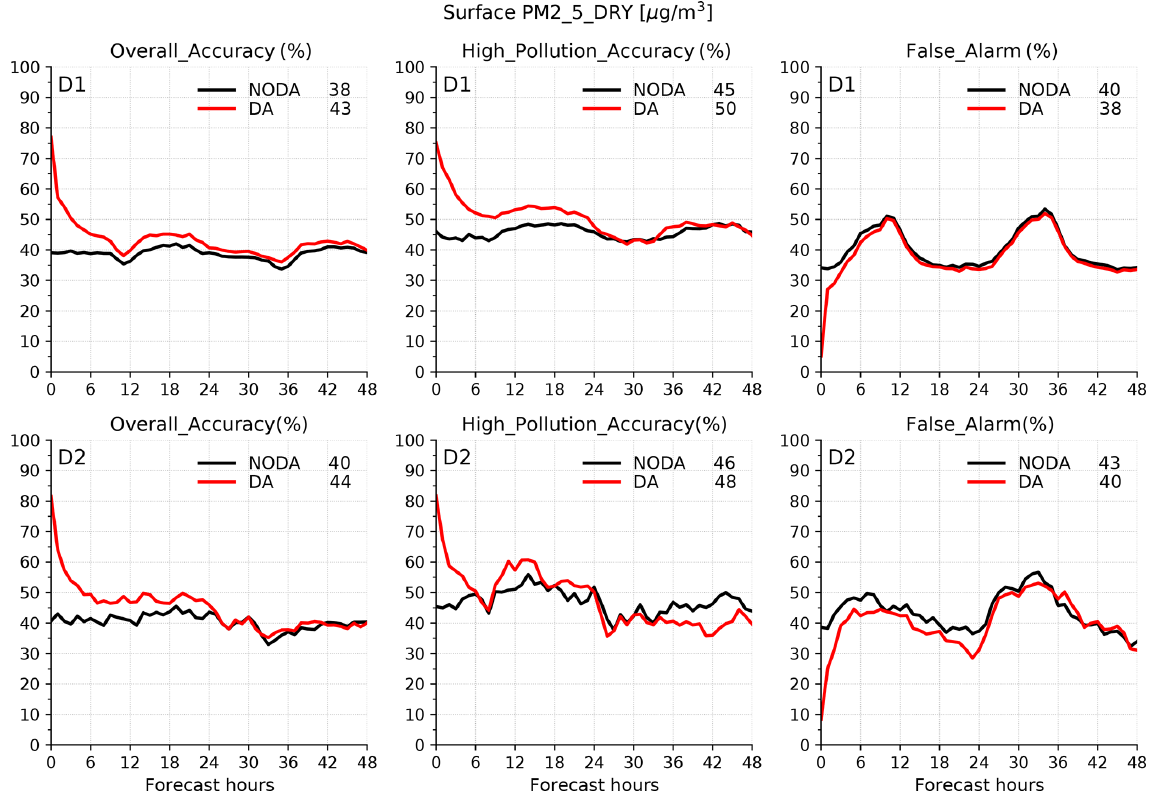
Figure 13. Same as Fig. 12 but for the forecast accuracy (%) for categorized events, as defined in Tables 4 and 5. The 48h mean forecast accuracy of each experiment is shown in the